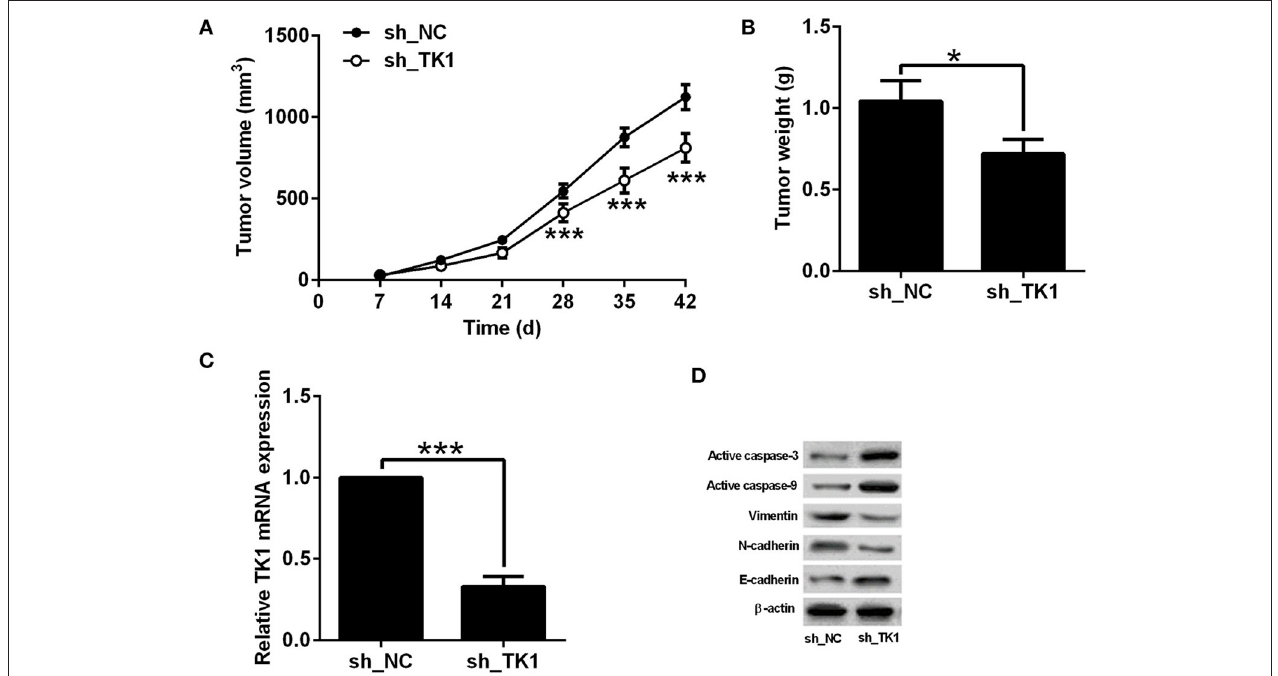
FIGURE 4 | Thymidine kinase 1 (TK1) knockdown suppressed in vivo tumor growth of thyroid carcinoma cells. (A) In vivo tumor growth of TPC-1 cells from sh_NC group and sh_TK1 group. (B) Weight of the tumor tissues from sh_NC and sh_TK1 group. (C) qRT-PCR analysis of TK1 mRNA expression levels in tumor tissues from sh_NC and sh_TK1 groups. (D) Western blot analysis of active caspase-3, caspase-9, vimentin, N-cadherin, and E-cadherin protein expression levels of the tumor tissues from sh_NC and sh_TK1. N = 6; * P < 0.05 and *** P < 0.001.